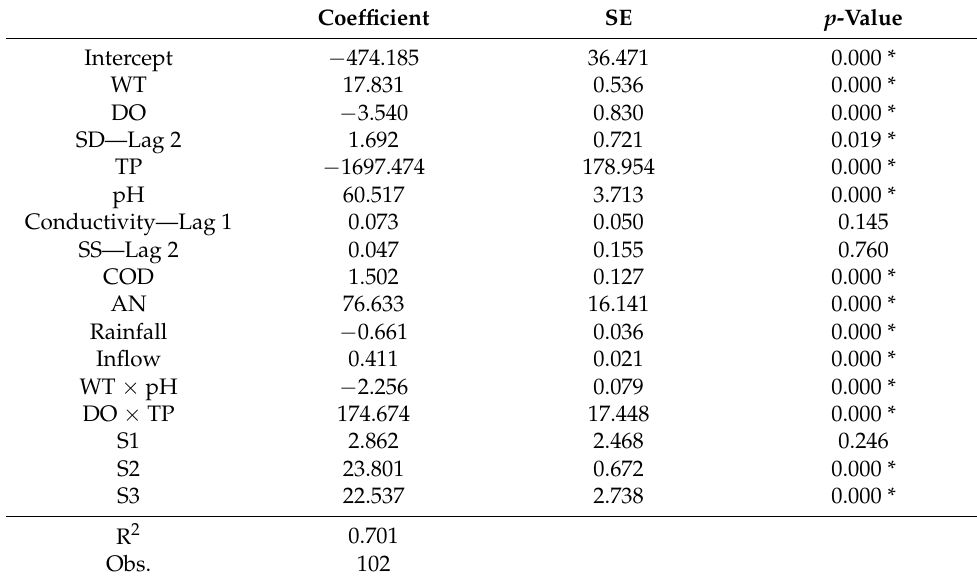
Table 6. Results from regression analyses of the Mingde Reservoir data.